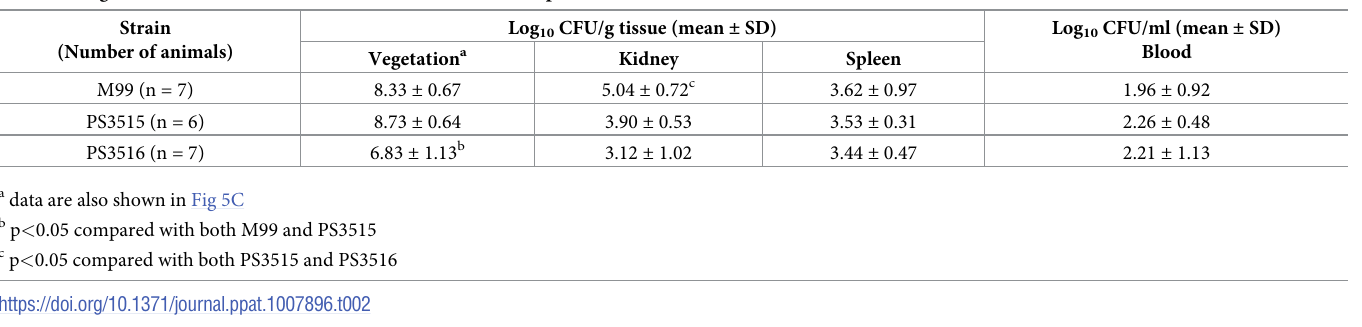
PLOS Pathogens| https://doi.org/10.1371/journal.ppat.1007896 June 24,